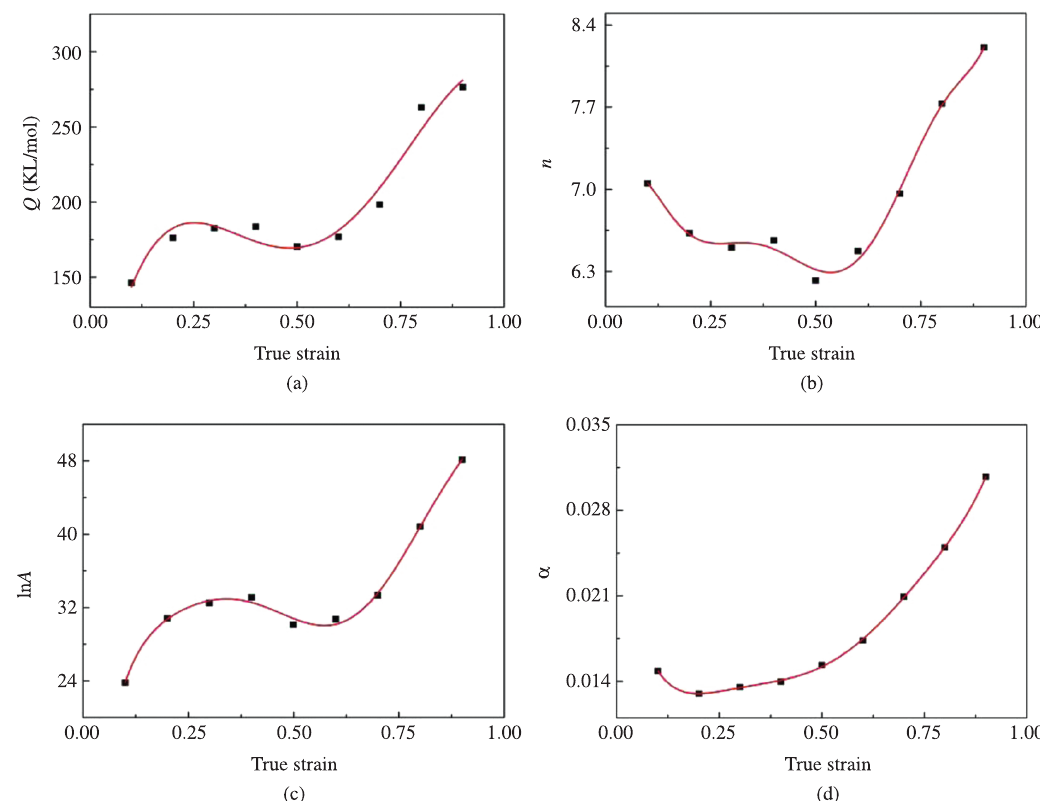
Figure 5. Relationship between: (a) Q ; (b) n ; (c) ln A ; (d) α and true strain by polynomial fit of AZ80 magnesium